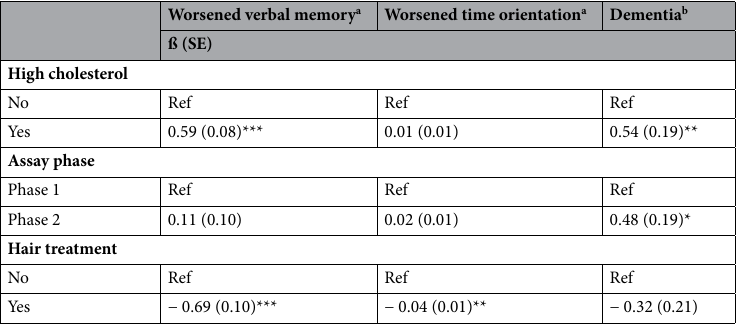
Table 2. Unadjusted regression models of hair cortisol and cortisone as the exposures and cognitive performance and dementia as the outcomes. *P < 0.05, **P < 0.01, ***P < 0.001. a Linear random effect models were used to investigate the associations of hair cortisol and cortisone with worsened verbal memory and time orientation. b Cox regression model was used to investigate the associations of hair cortisol and cortisone with dementia. c The models were derived from the sample used to investigate the associations of hair cortisol with worsened verbal memory, worsened time orientation, and dementia. d Age and depression score were treated as continuous